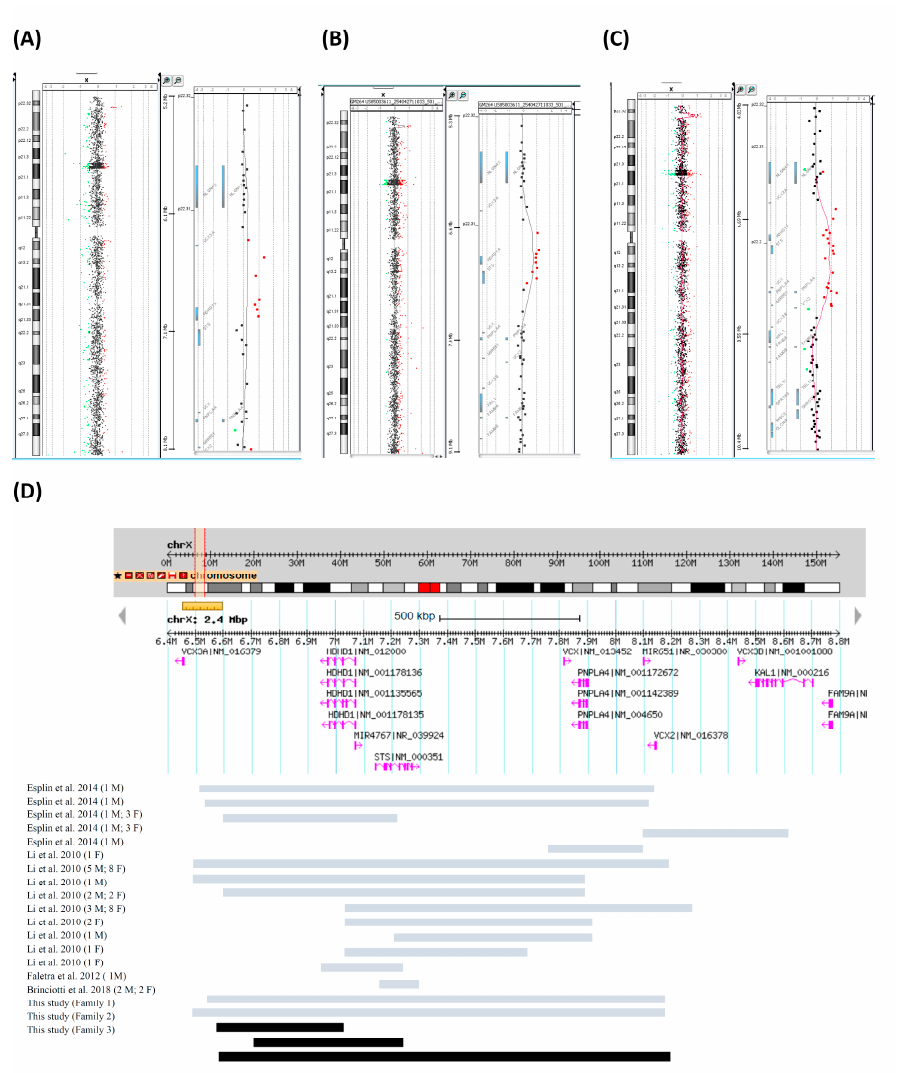
Figure 2. The Xp22.31 microduplications detected in the male fetuses of ( A ) Family 1 (F1-III-1: arr[GRCh37] Xp22.31(6552712_7033316) × 2mat), ( B ) Family 2 (F2-III-2: arr[GRCh37] Xp22.31(6705268_7218859) × 2mat), and ( C ) Family 3 (F3-III-2: arr[GRCh37] Xp22.31(6552712_8115153) × 2mat). ( D ) Comparison of the breakpoints and genes included in Xp22.31 microduplications between our cases and the available published data. Previously reported cases indicated by gray bars and cases shown in this report indicated by black